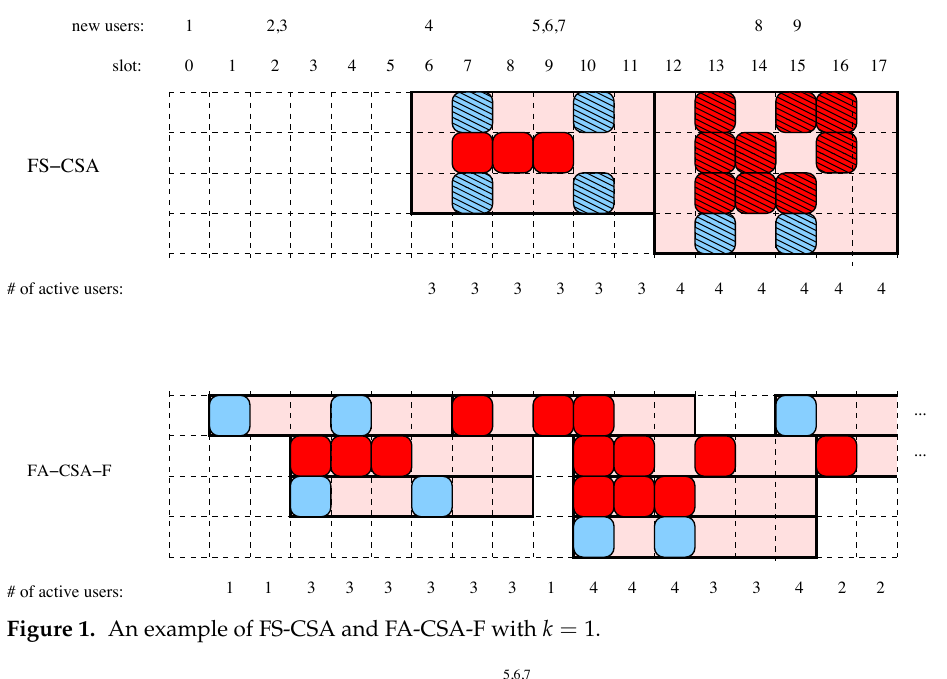
Figure 1. An example of FS-CSA and FA-CSA-F with k = 1.